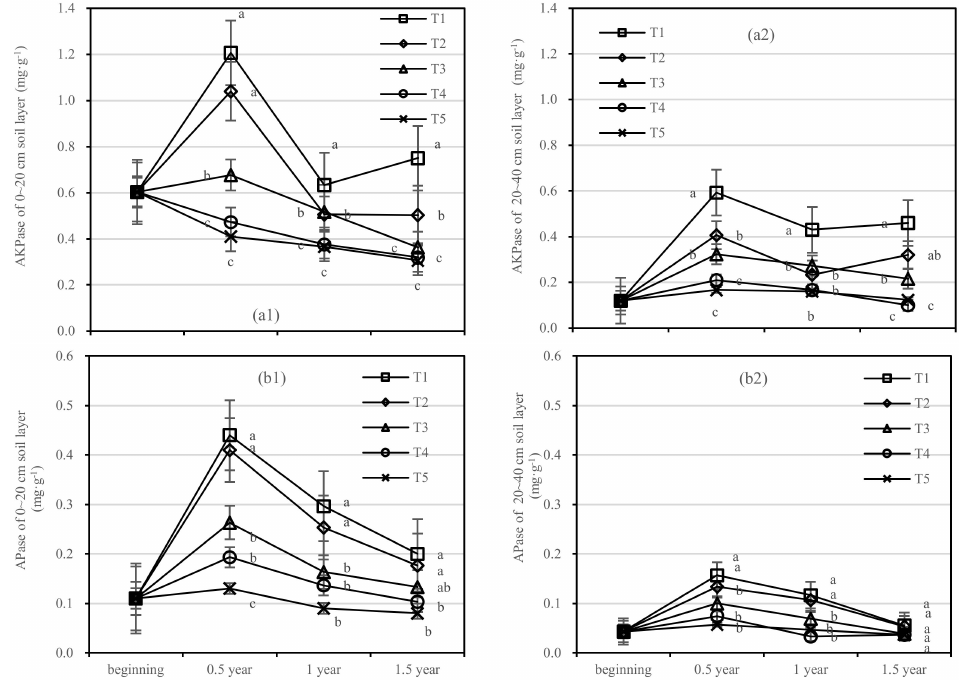
Figure 7. Soil AKPase and APase activities in four periods under five fertilization types. Data are the mean content ± standard deviation. Letters represent differences ( α = 0.05). T1: adjustment of C/N and C/P + 0.2% priming; T2: adjustment of C/N and C/P + 0.2% common compost; T3: adjustment of C/N and C/P; T4: raw material grinding of thinning shreds; T5: no fertilization. Additionally, ( a1 , a2 ) and ( b1 , b2 ) describe the contents of soil AKPase and APase activities in the 0–20 cm and 20–40 cm soil layers,